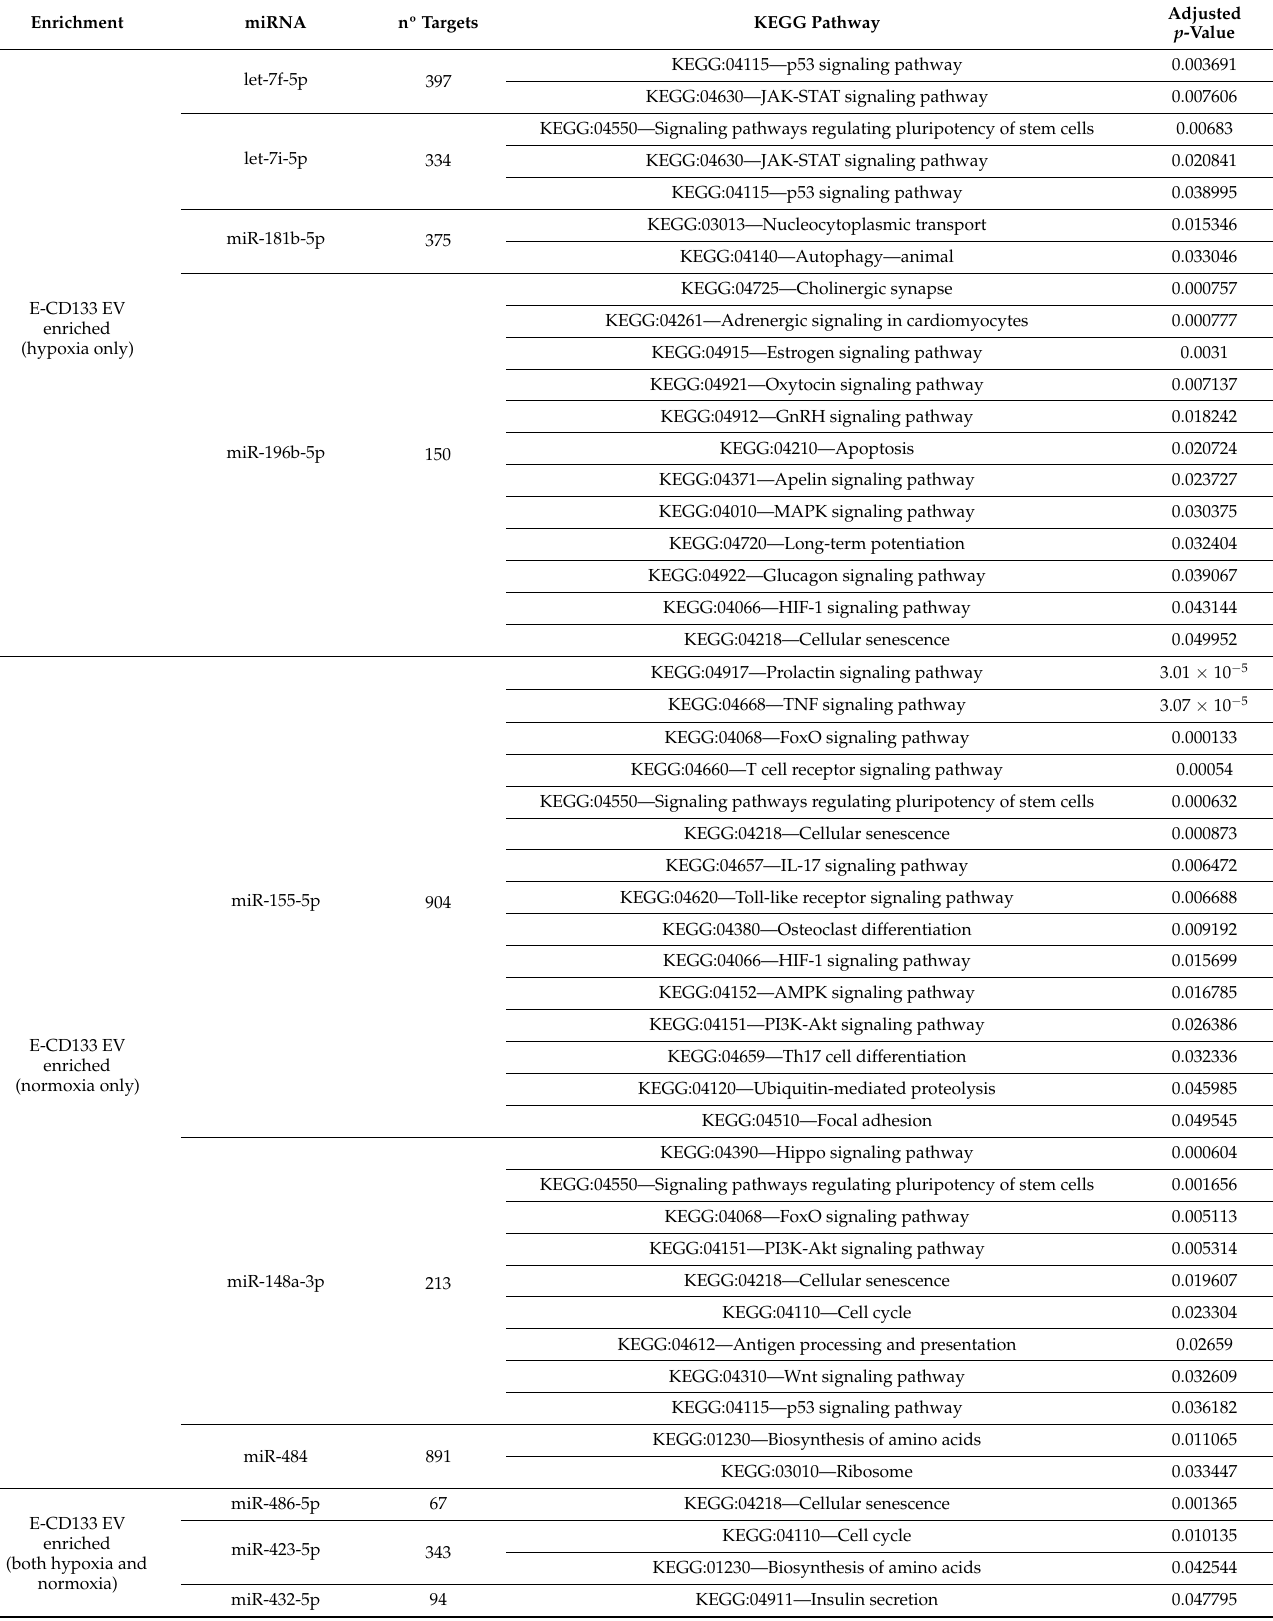
Table 1. KEGG pathways identified from targets for each miRNA enriched in E-CD133